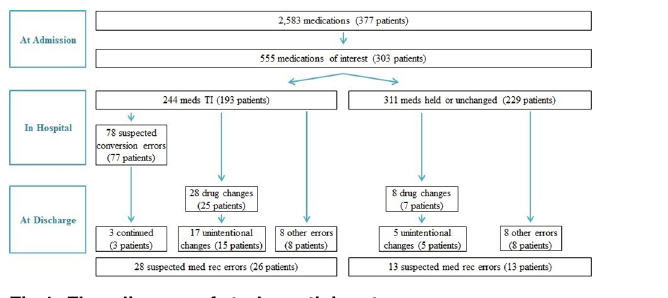
Fig 1. Flow diagram of study participants.